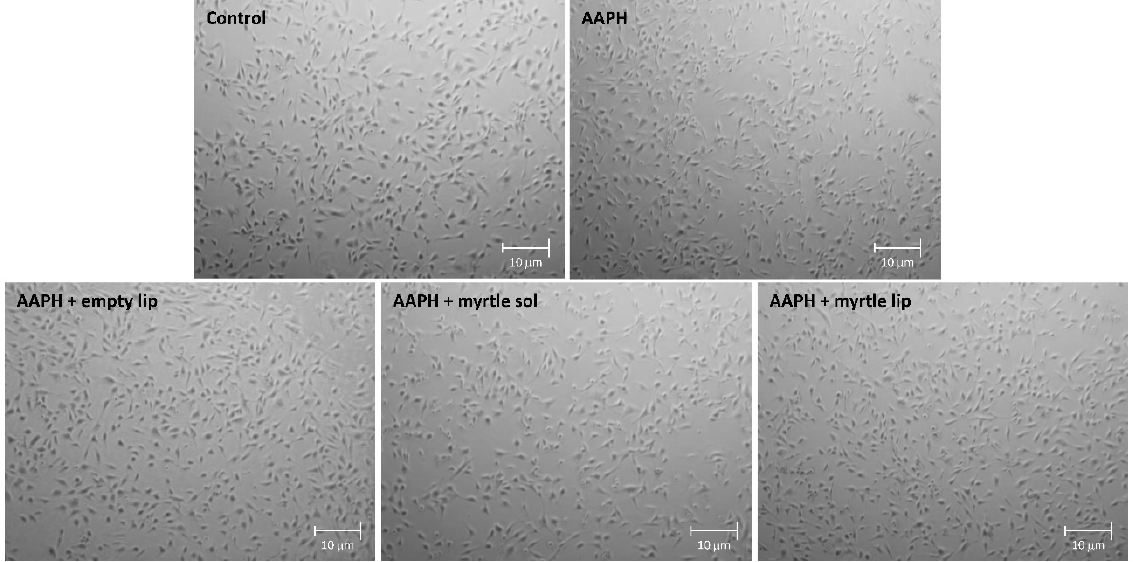
Figure 6. Representative microscope images of untreated 3T3-L1 cells in comparison with cells stressed with 500 μM AAPH or stressed with AAPH and treated with empty liposomes, myrtle solution, and myrtle liposomes for 5 h.